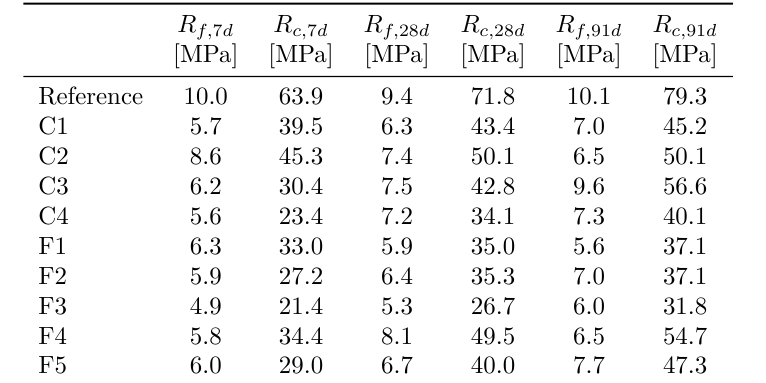
Table 9. Mechanical properties of the mortar mixtures with alternative binders and supplementary cementitious